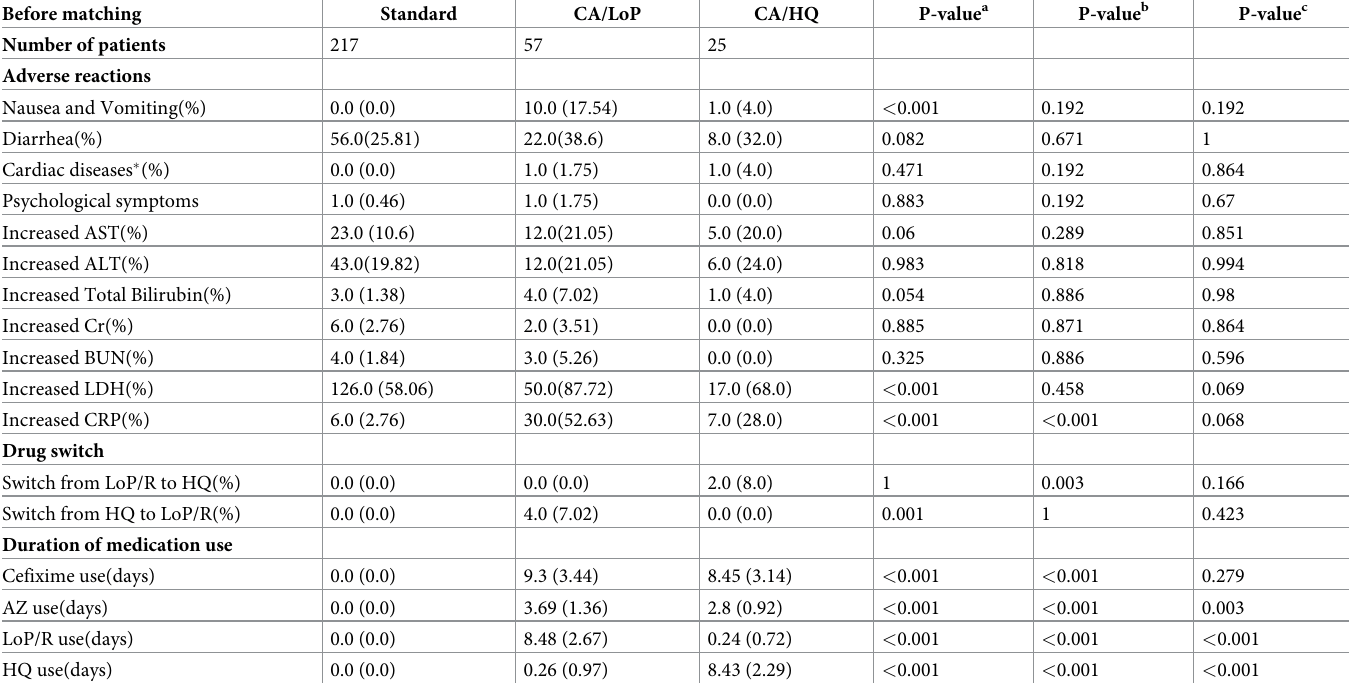
Table 4. Adverse effects and drug switch percentage before propensity score